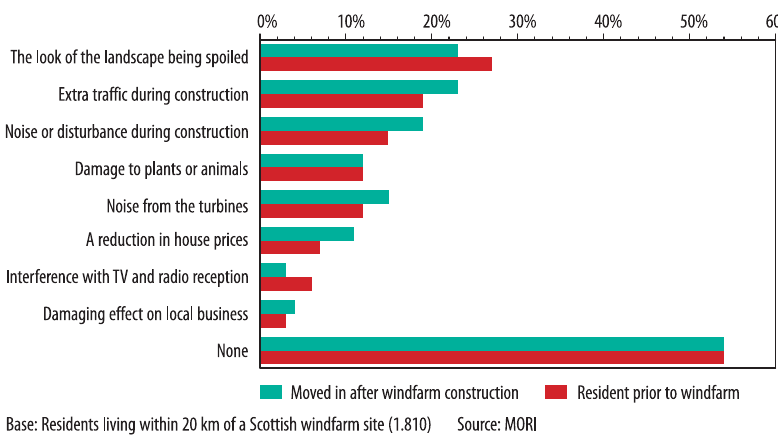
Figure 3. Perceived problems caused by wind